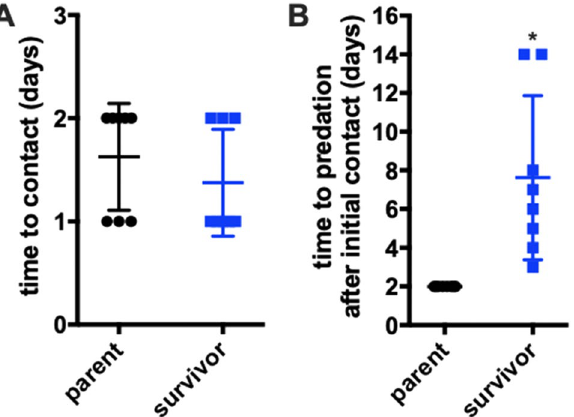
Figure 3. Predatory avoidance trait of survivor P. putida is contact dependent. Modified distant spot predation assay data with prey introduced 2 cm from C. ferrugineus depicting ( A ) no statistical differences in time to predator–prey contact (n = 8) and ( B ) significant differences in time to predation after contact (predation considered complete swarming of prey biomass) (n = 8; p ≤ 0.01). Statistical significance calculated using an unpaired t test with Welch’s correction.